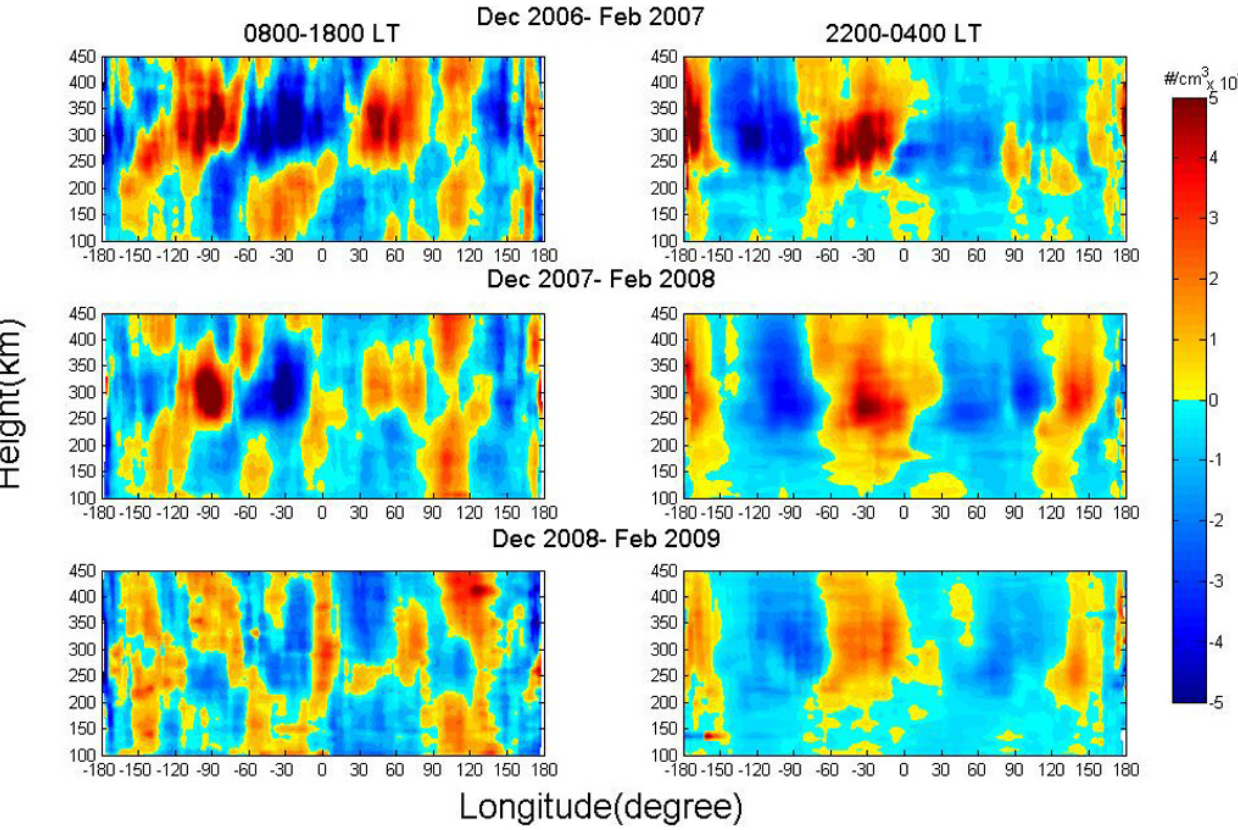
Fig. 3. Same as Fig. 2 but for December solstice in 2006, 2007 and